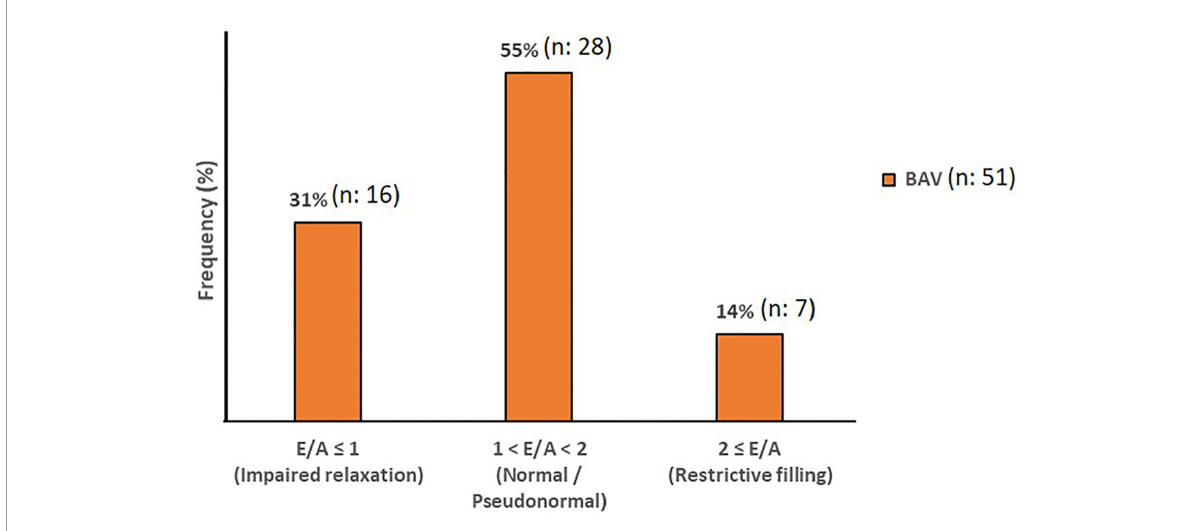
FIGURE5 Diastolic Function. The mitral filling patterns categories in BAV with mild regurgitation groups. Normal and Pseudonormal subjects are considered in the same